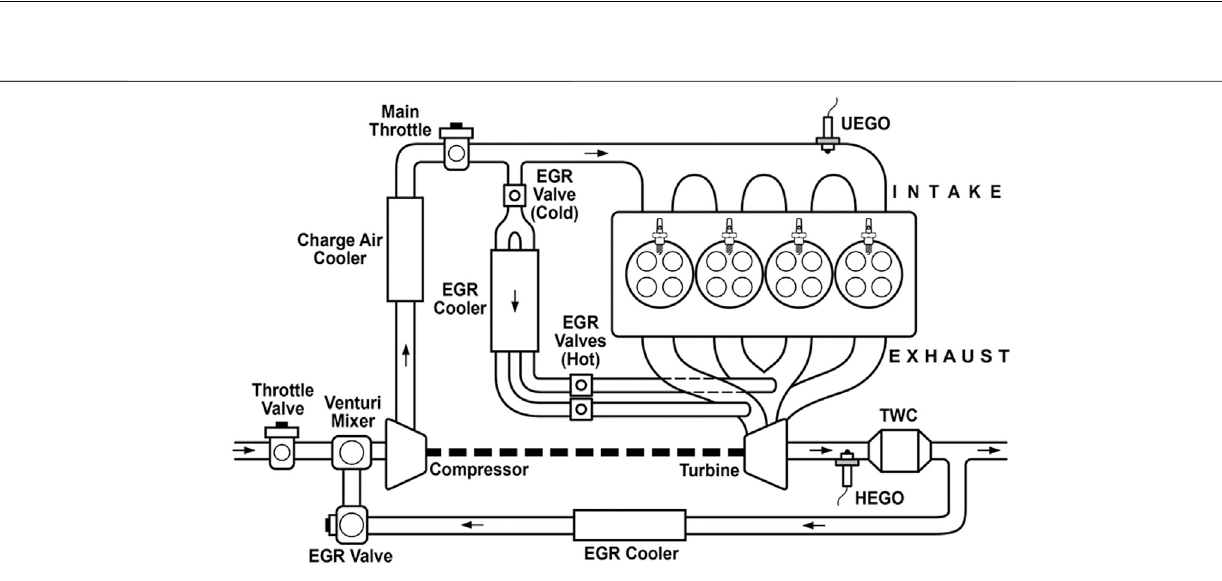
FIGURE 6 | Blended EGR con fi